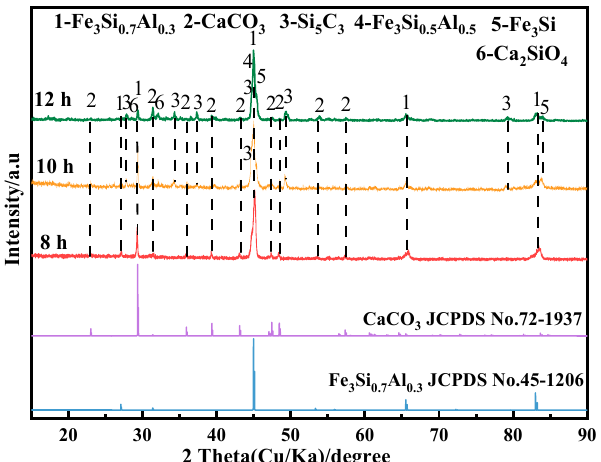
Figure 7. XRD patterns of the solid cathode electrolyzed in CaCl 2 –NaCl molten salt at 800 °C at a constant voltage of 3.2 V for 12 h.